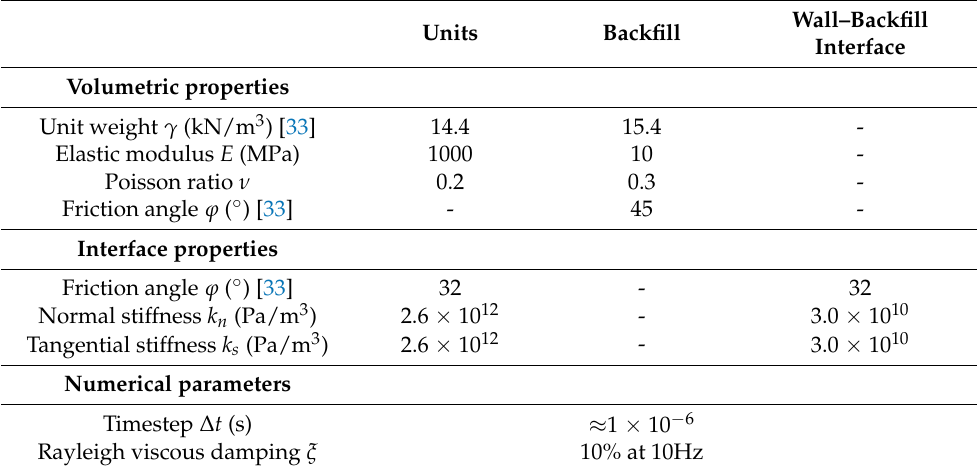
Table 1. Properties used for the numerical simulations of the scaled-down experimental